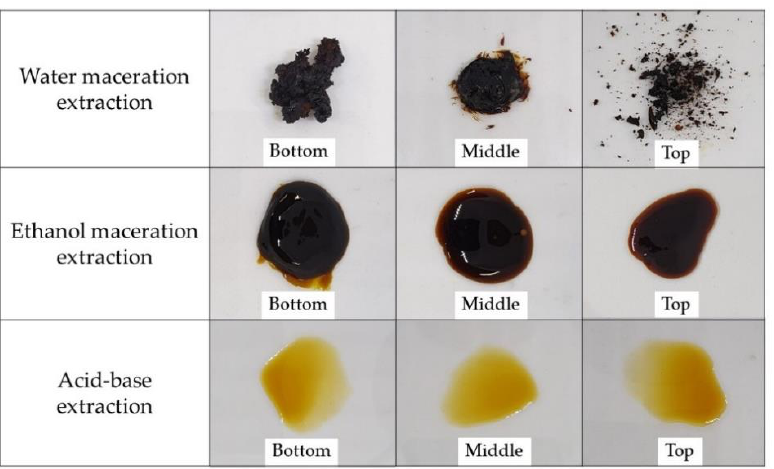
Figure 2. Tobacco leaf extract from different leaf positions using the maceration extraction method with water and ethanol as well as the acid-base extraction method. Table 1. Yield extract percentage and nicotine (NCT) content from different extraction methods and parts of tobacco leaves. Tobacco Leaf Extract